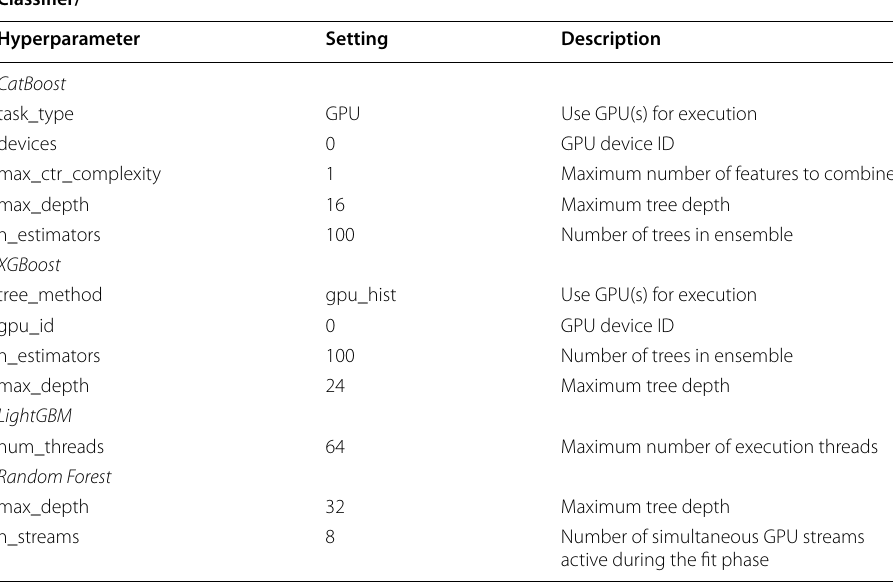
Table 4 Changed hyperparameter